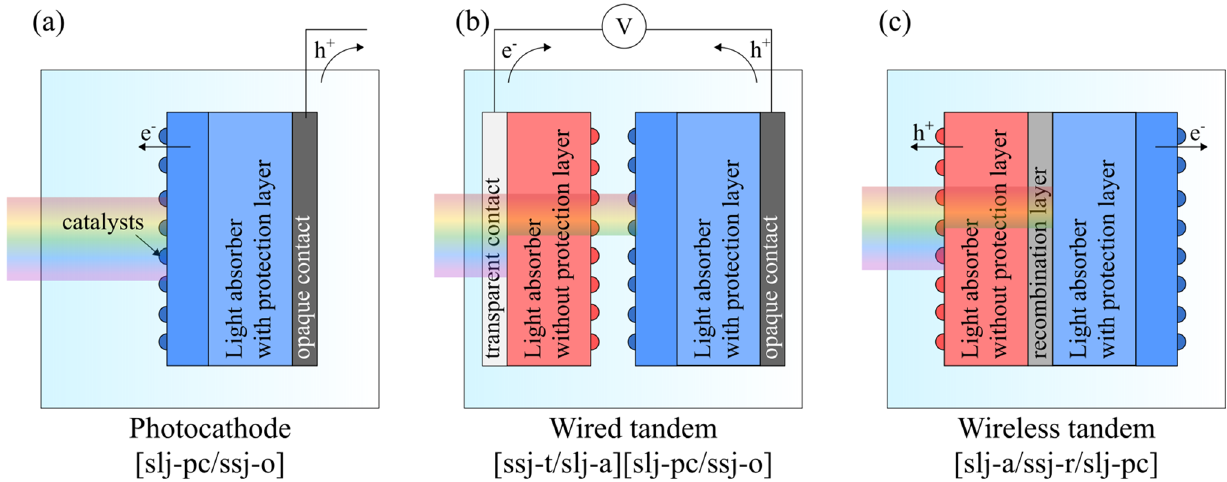
Fig. 2 Schematic drawing of the selected PEC device structures. The classification scheme introduced in this study is explained with the selected PEC device structures as examples. In this classification scheme, a photocathode with a protection layer, b wired tandem, and c wireless tandem devices. In both b and c , a wider bandgap top cell serves as a photoanode and a lower bandgap bottom cell as a photo-